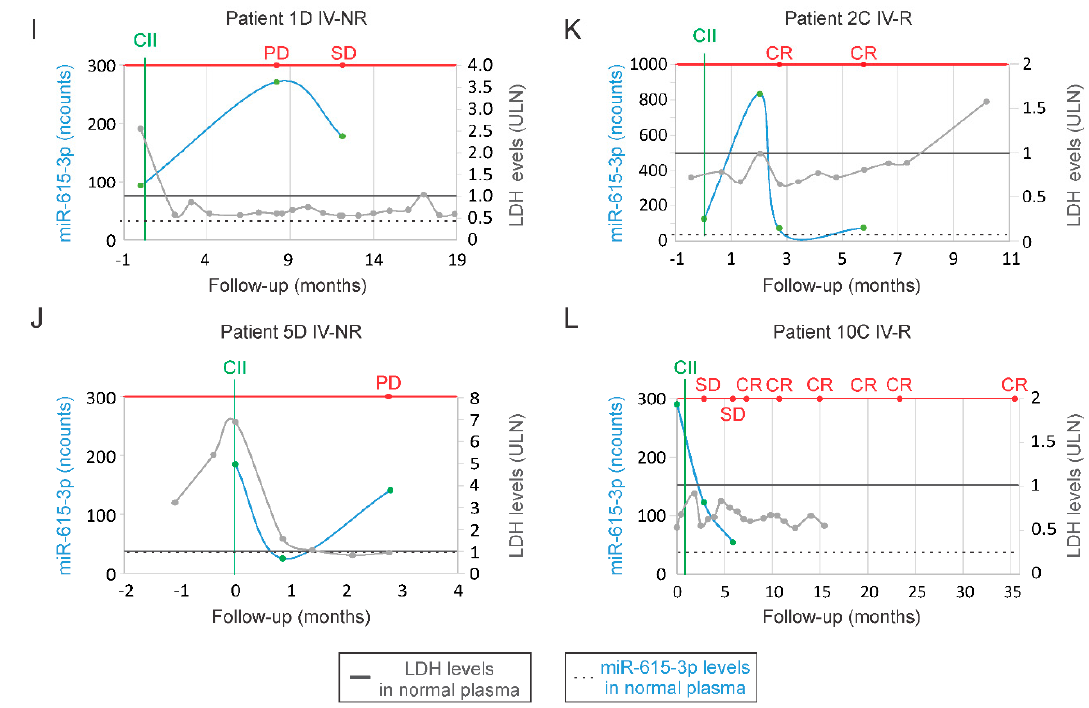
Figure 3. Validation of cfmiRs identified in assessing patient response to CIIs. ( A , B ) Disease status in stage IV patients who had a complete response ( A , CR) or partial response ( B , PR). Orange stars indicate pre-treatment (Pre) plasma samples. Red circles indicate blood collected in patients at CR. Red squares indicate blood collected in patients at PR. ( C – E ) Boxplots showing the changes in miR-4649-3p ( C ), miR-615-3p ( D ), and miR-1234-3p ( E ) levels in patients who achieved a CR ( p values are indicated on top) compared to pre-treatment samples. ( F – H ) Boxplots showing the changes in miR-4649-3p ( F ) and miR-615-3p ( G ), and miR-1234-3p ( H ) levels in patients who achieved PR compared to pre-treatment samples (NS, non-significant). ( I – L ) Graph showing four melanoma patients: stage IV non-responder (IV-NR) patient 1D ( I ) or patient 5D ( J ); stage IV responders (IV-R) patient 2C ( K ) or patient 10C7 ( L ). Shown is the follow-up in months, LDH levels (labeled as light gray), and miR-615-3p levels (labeled as light blue; normalized counts, ncounts) at the indicated time points. Red line points to RECIST 1.1. Gray solid line indicates the upper limit normal (ULN) for LDH. Black dotted line indicates the average level of miR-615-3p detected in normal healthy donors’ plasma samples. Green solid line indicates the start of